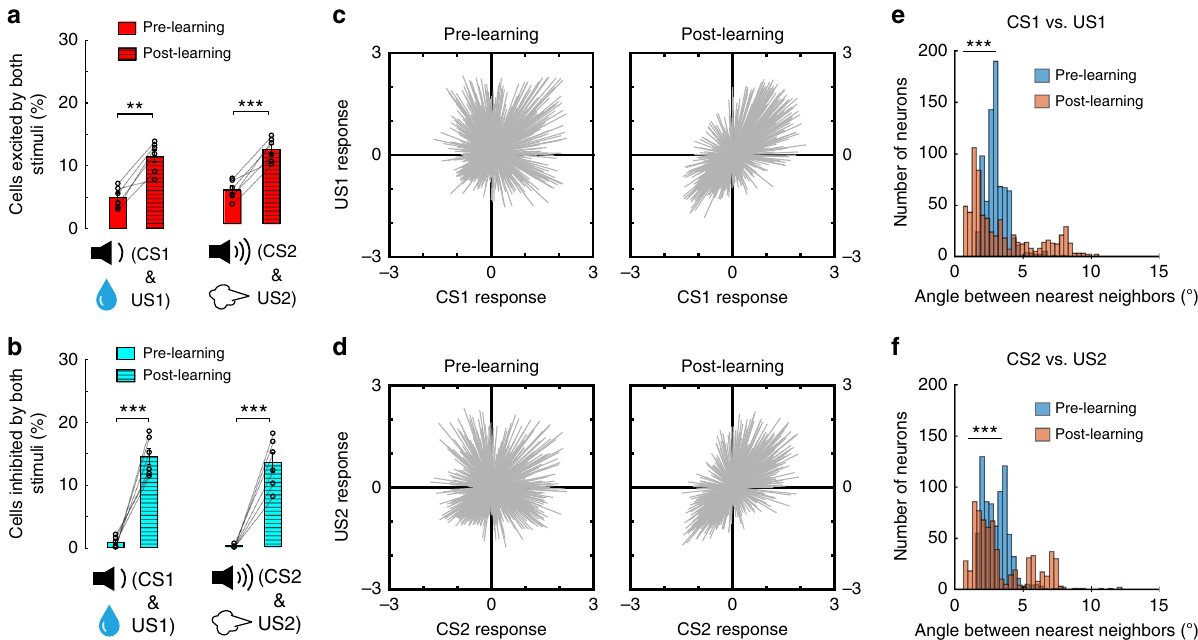
Fig. 5 Learning links CS and US representations in the BLA. a The percentage of BLA neurons showing excitatory responses to both CS and US ( n = 6 mice; CS1 & US1, t (5) = − 6.116, ** P = 0.0017; CS2 and US2, t (5) = − 9.2, *** P = 2.5e − 4; paired t -test). b The percentage of BLA neurons showing inhibitory responses to both CS and US ( n = 6 mice; CS1 and US1, t (5) = − 8.8, *** P = 3.12e − 4; CS2 and US2, t (5) = − 8.3, *** P = 4.11e − 4; paired t -test). c , d The responses to CS1 and US1 ( c ), or to CS2 and US2 ( d ), for each neuron. Each line is a vector representing the responses of a particular neuron to both the CS and the US (values represent z -scores). Note that before learning, the vectors are distributed uniformly in the four quadrants, whereas after learning, the vectors are more concentrated in quadrants I and III. e The distribution of angles between the nearest neighbors among vectors in ( c ) (pre-learning median, 3.89, n = 756 neurons, post-learning median, 2.36, n = 677 neurons, z = 4.73, *** P = 2.26e − 6, rank sum test). f The distribution of angles between the nearest neighbors among vectors in ( d ) (pre-learning median, 3.93, n = 756 neurons, post-learning median, 2.60, n = 677 neurons, z = 5.3, *** P = 1.42e − 7, rank sum